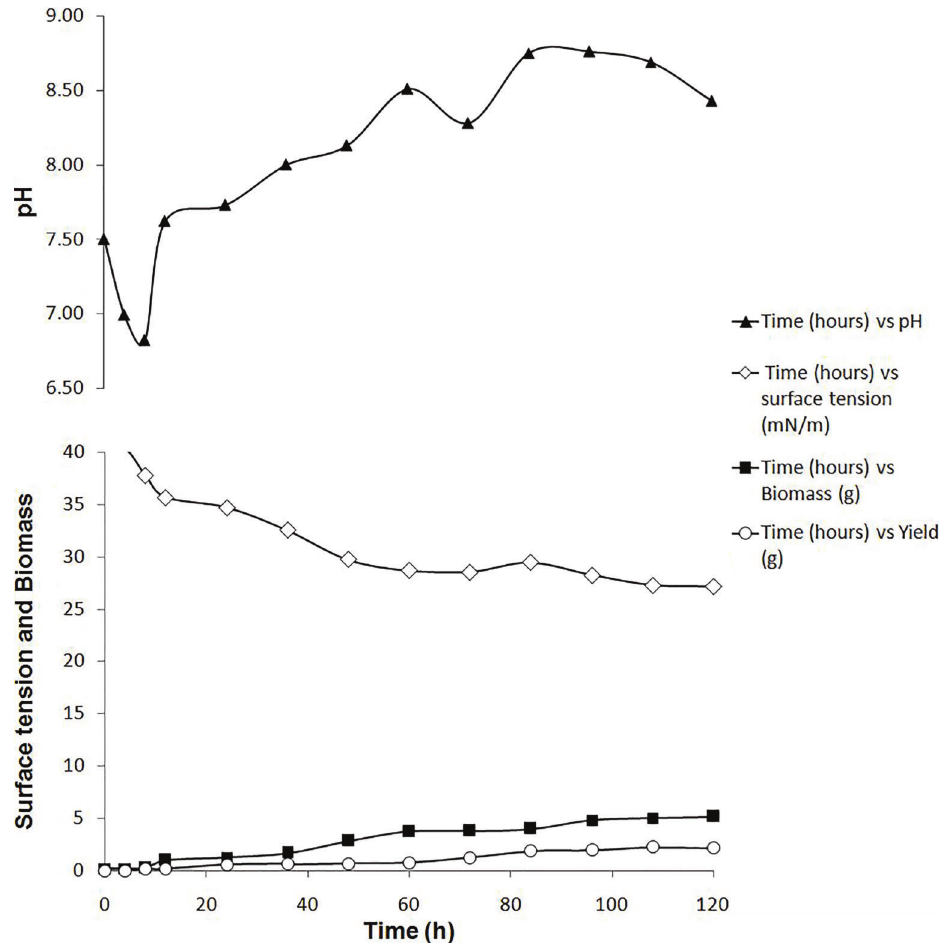
Figure 2. Kinetics of growth, pH, surface tension and biosurfactant production after 120 h of fermentation.